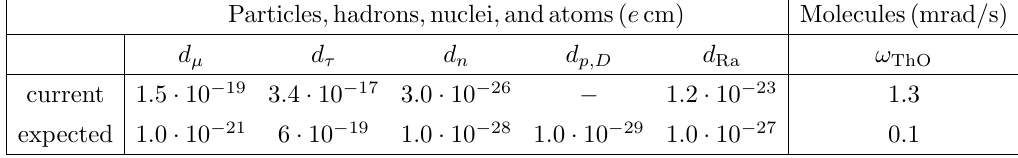
Table 4 . Expected sensitivities of several promising future EDM experiments, see refs. [13,